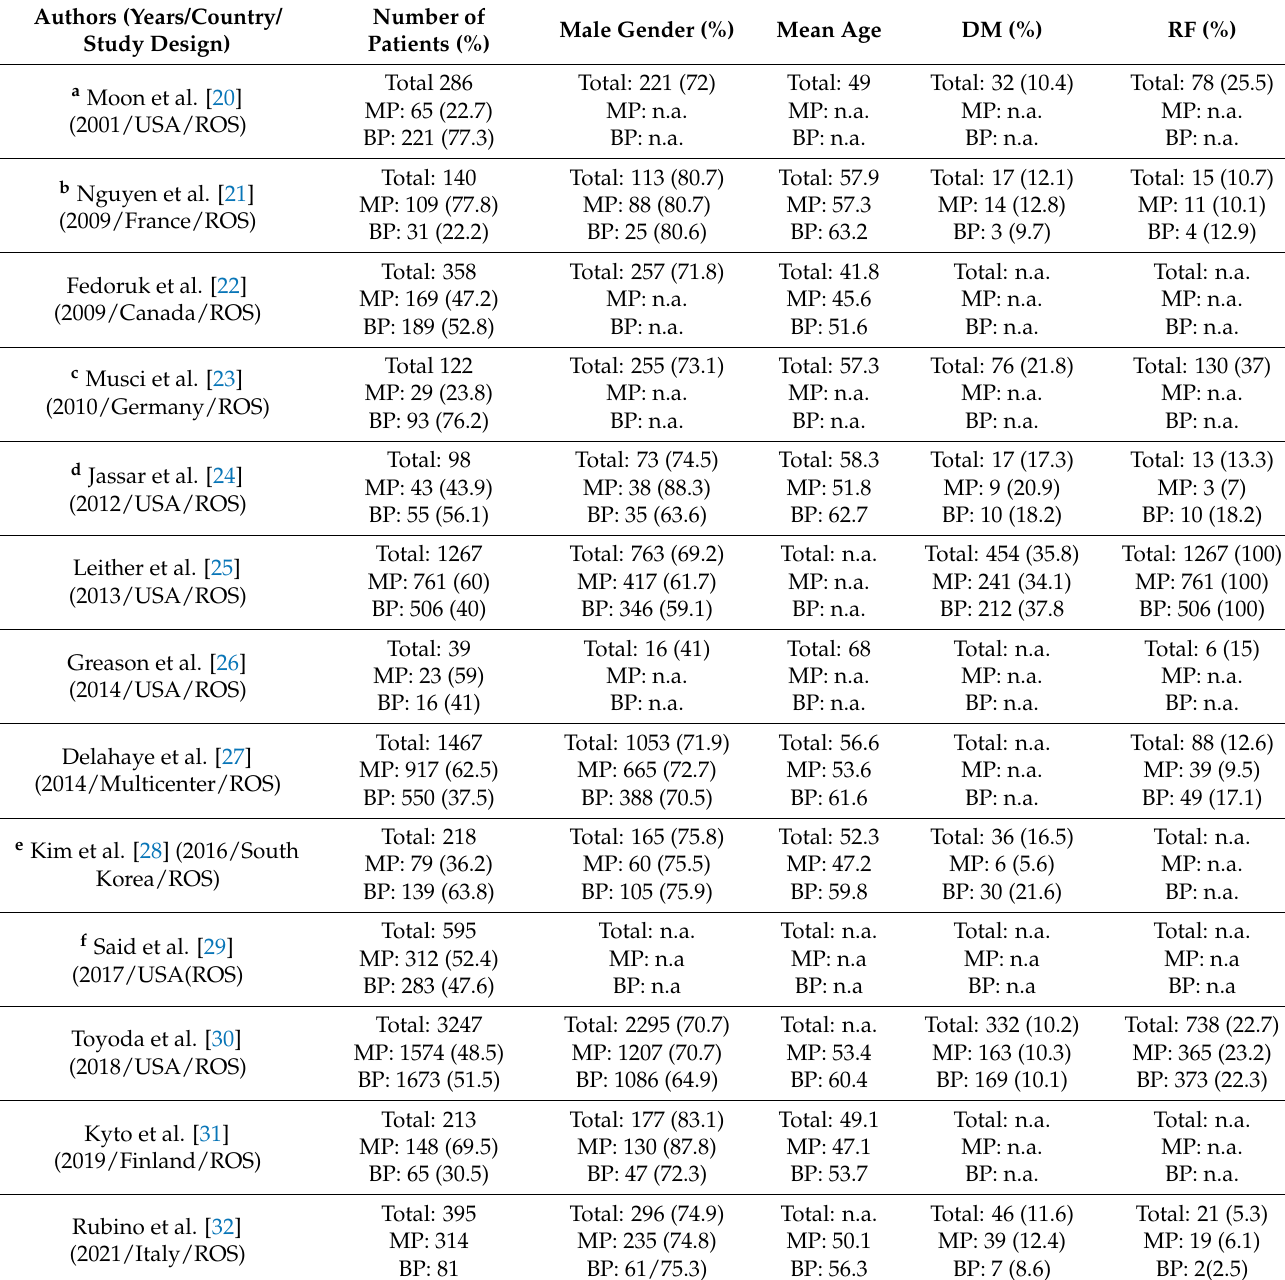
Table 1. Study typology and patients’ characteristics: ( a ) total patients do not include 20 homografts; ( b ) total patients do not include 27 homografts; ( c ) total patients do not include 103 homografts; ( d ) total patients do not include 36 homografts; ( e ) total patients do not include 86 homografts; and ( f ) total patients do not include 283 homografts and 122 valve repairs. Abbreviations: MP, mechanical prosthesis; BP, biological prosthesis; ROS, retrospective observational study; and n.a., not